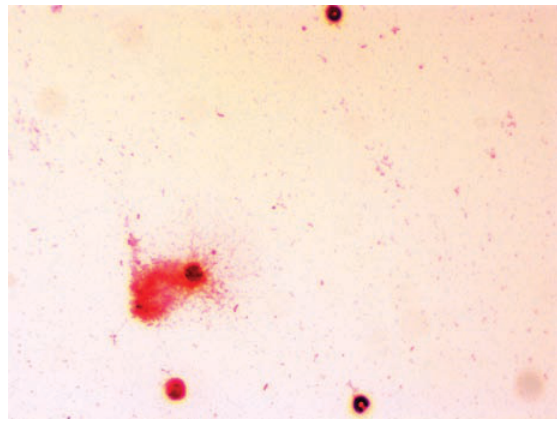
Figure 3. Gram stain of the Cerebrospinal fluid.